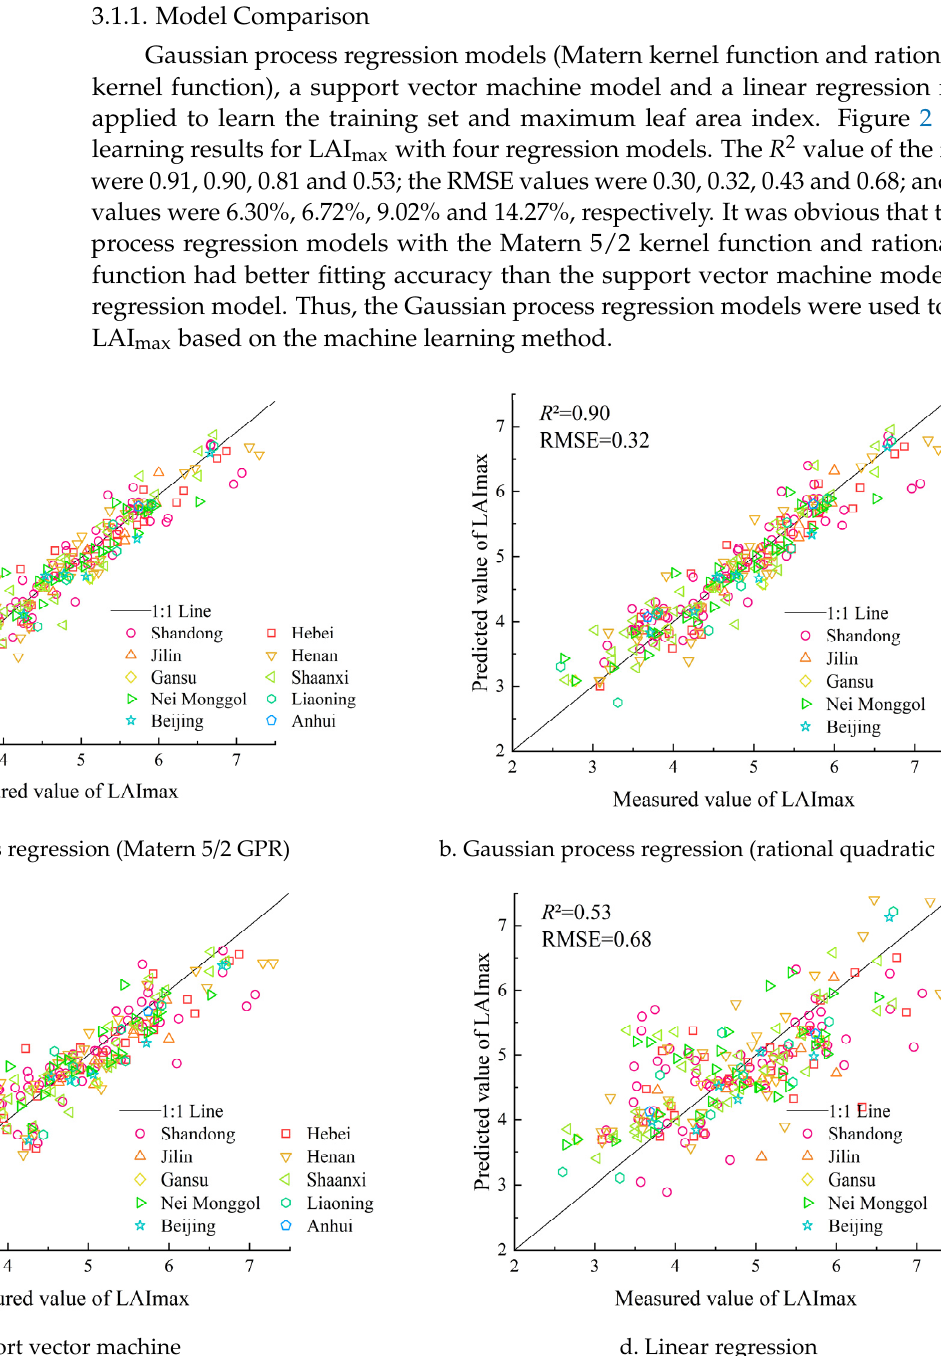
Figure 2. Regression model for maximum leaf area index for summer maize.